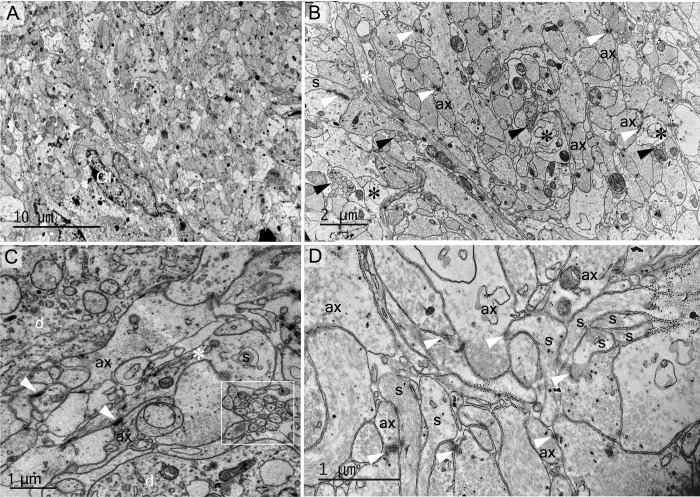
Electron micrographs illustrating the complex organisation of the supraoptic nucleus dendritic zone.(A, B) Dendrites of magnocellular neurones are found with glial cells (Gl) and their processes (light asterisk in B). From these dendrites derive spines (dark arrowheads) that make synaptic contact with axons terminals (ax). Degenerating elements also are observed (dark asterisks in B). (C) A cluster of spines (square) near large dendrites (d). One appears with an apparent neck (asterisk) and head (S) making synaptic contact (arrowheads) with axon terminals (ax). (D) Two clusters of dendritic spines (s and s') organised in bundles and connected to presynaptic elements (arrowheads).